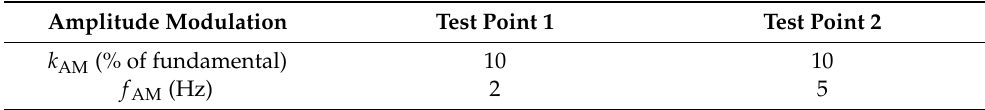
Table 8. Proposed test point for amplitude